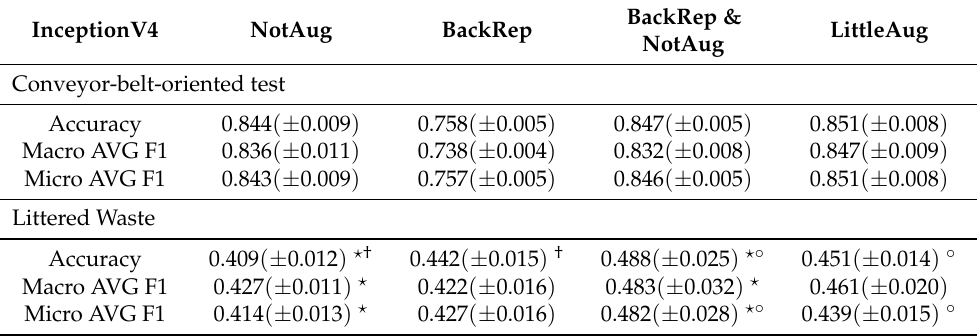
Table 5. Accuracy, Macro Average F1 and Micro Average F1 of InceptionV4 with the 4 different configurations. InceptionV4 is trained on the conveyor-belt-oriented training set and tested on the conveyor-belt-oriented and on the Littered waste testing sets. Results report the average and the standard deviation of 5 runs with different seeds. The symbols †, (cid:63) and ◦ indicate a statistically significant difference between two results with a 95% of confidence level with the Student’s t